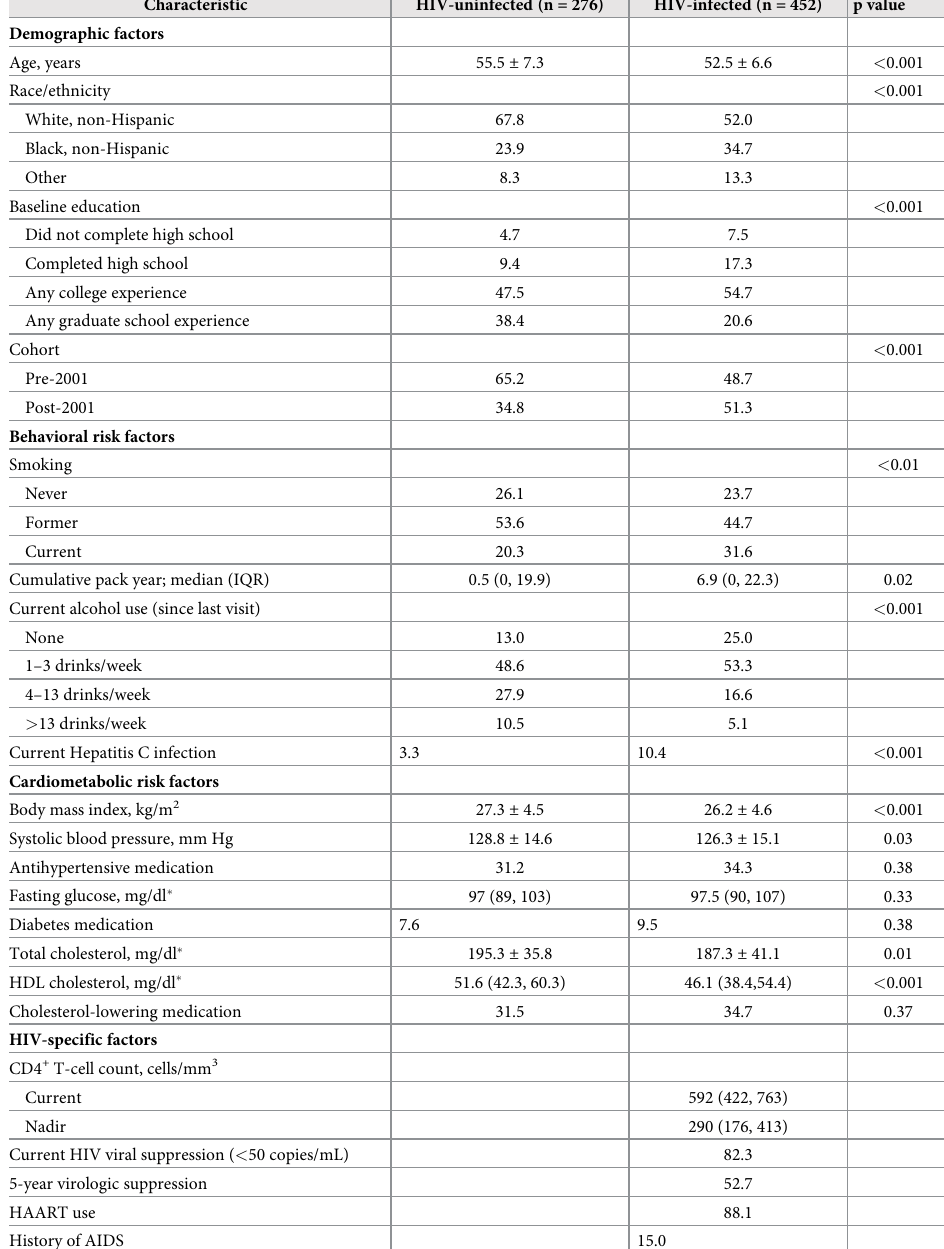
Table 1. Study population characteristics, by HIV